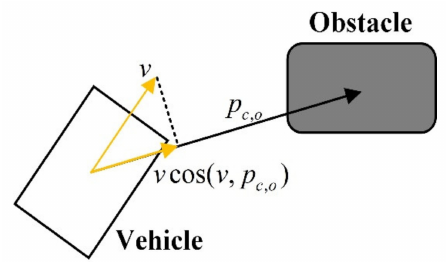
Figure 4. Diagram of the calculation of TTC